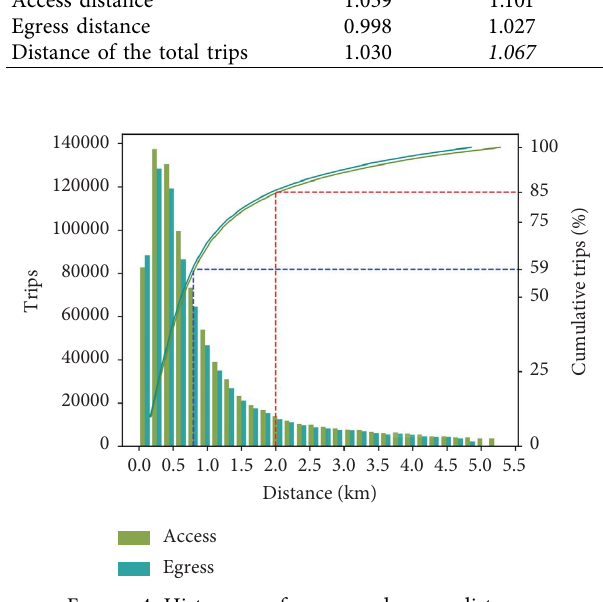
Figure 4: Histogram of access and egress